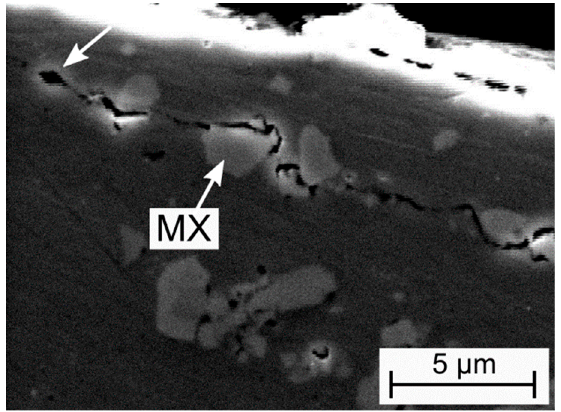
Figure 9. E ff ect of MX-type precipitates on the crack propagation in the steel 5Mo-2W; the arrow marks the crack stop in the subsurface